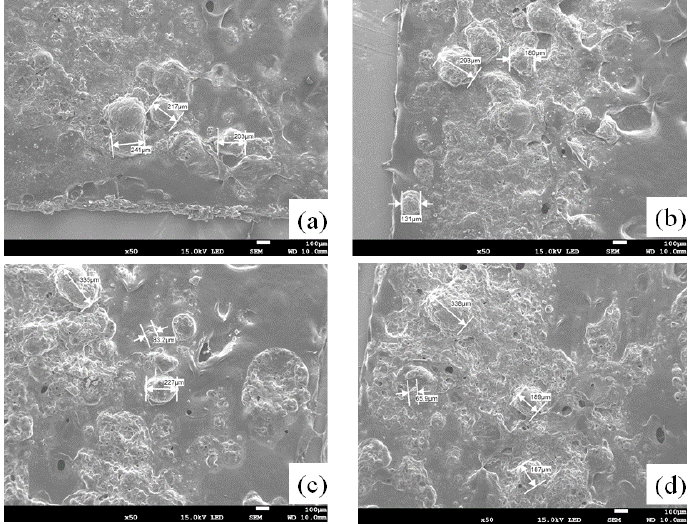
Figure 13. SEM images of different ball milling times. ( a ) Ball milled the powder for 1 h with a steel balls ratio of 1:4; ( b ) ball milled the powder for 2 h with a steel balls ratio of 1:4; ( c ) ball milled the powder for 3 h with a steel balls ratio of 1:4; ( d ) ball milled the powder for 4 h with a steel balls ratio of 1:4.